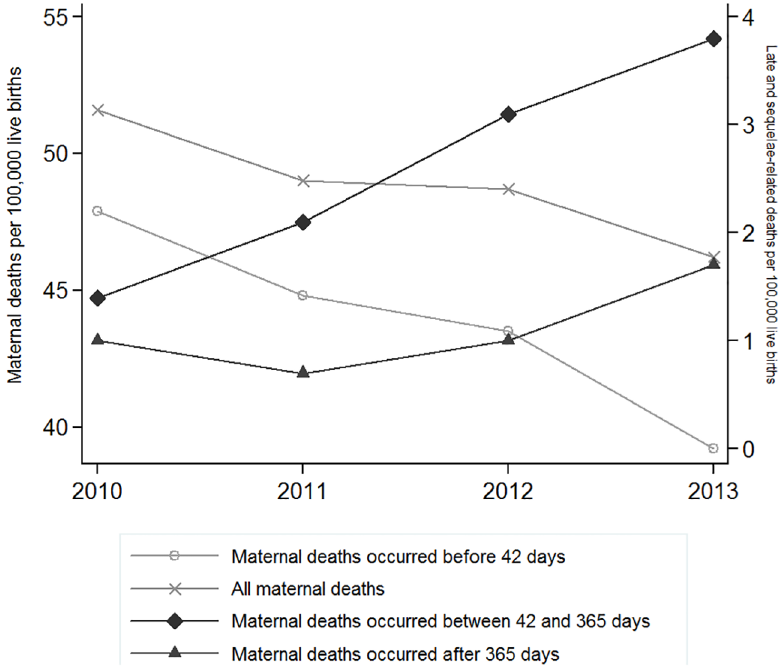
Fig 1. Trends of the Maternal Mortality Ratio by death categories (within 42 days, late and sequelae- related). Mexico 2010 – 2013.